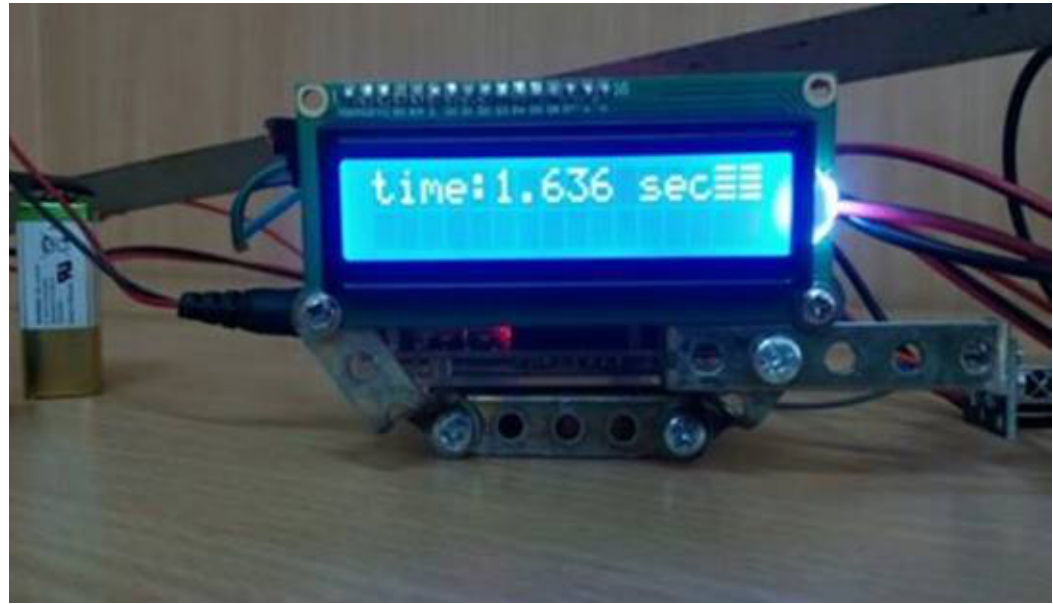
Figure 34: Presentation of paper [334].